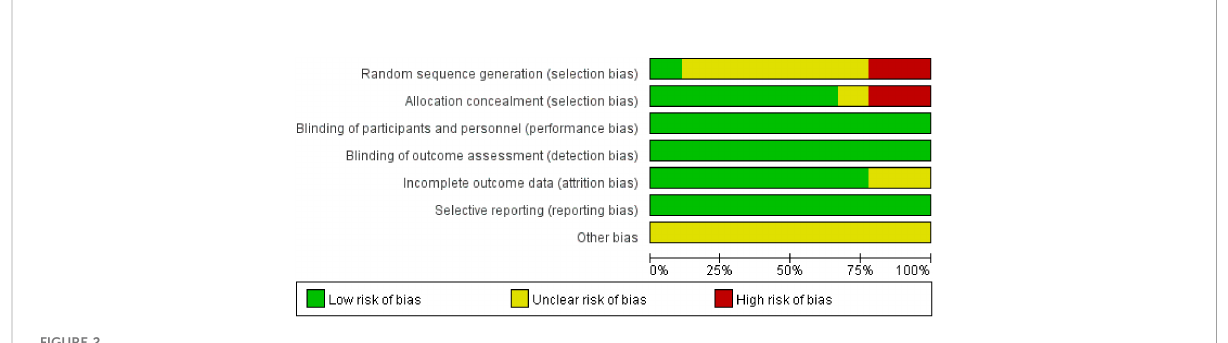
FIGURE 2 Percentage of included studies with the risk of